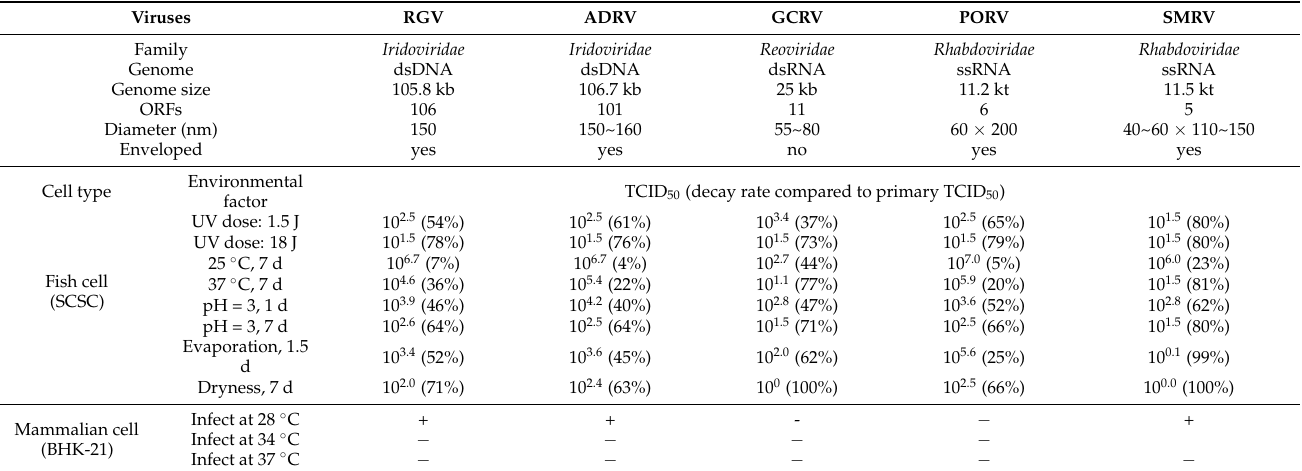
Table 1. TCID 50 (decay rates) of viruses under various environmental factors in fish cell and the infectivity in mammalian